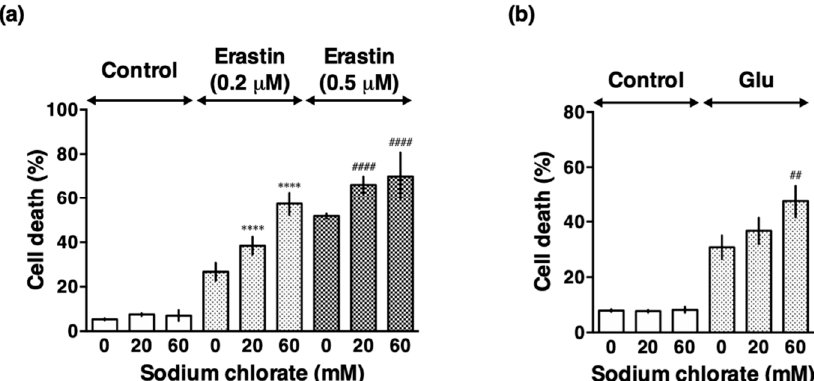
Figure 3. Sodium chlorate enhanced endogenous oxidative stress-induced cell death in HT22 cells. ( a ) E ff ect of sodium chlorate on erastin-induced cell death. HT22 cells were treated with 0.2 µ M or 0.5 µ M erastin in the presence or absence of sodium chlorate (20 or 60 mM) for 24 h and cell death was determined by LDH assay. ( b ) E ff ect of sodium chlorate on glutamate-induced cell death. HT22 cells were treated with 5 mM glutamate in the presence or absence of sodium chlorate (20 or 60 mM) for 24 h and cell death was determined by LDH assay. The data are presented as the mean ± SD. The data were obtained from at least four independent cultures. **** p < 0.0001, #### p < 0.0001 compared with 0.2 µ M or 0.5 µ M erastin alone; ## p < 0.01 compared with glutamate alone.